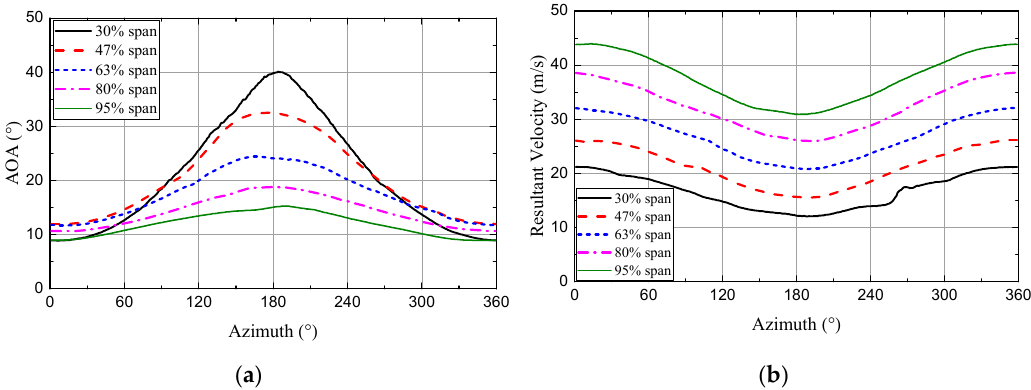
Figure 4. Azimuthal variations of the AOA and resultant velocity at 13 m/s wind speed and 30° yaw angle (S1300300). ( a ) AOA; ( b ) resultant velocity.